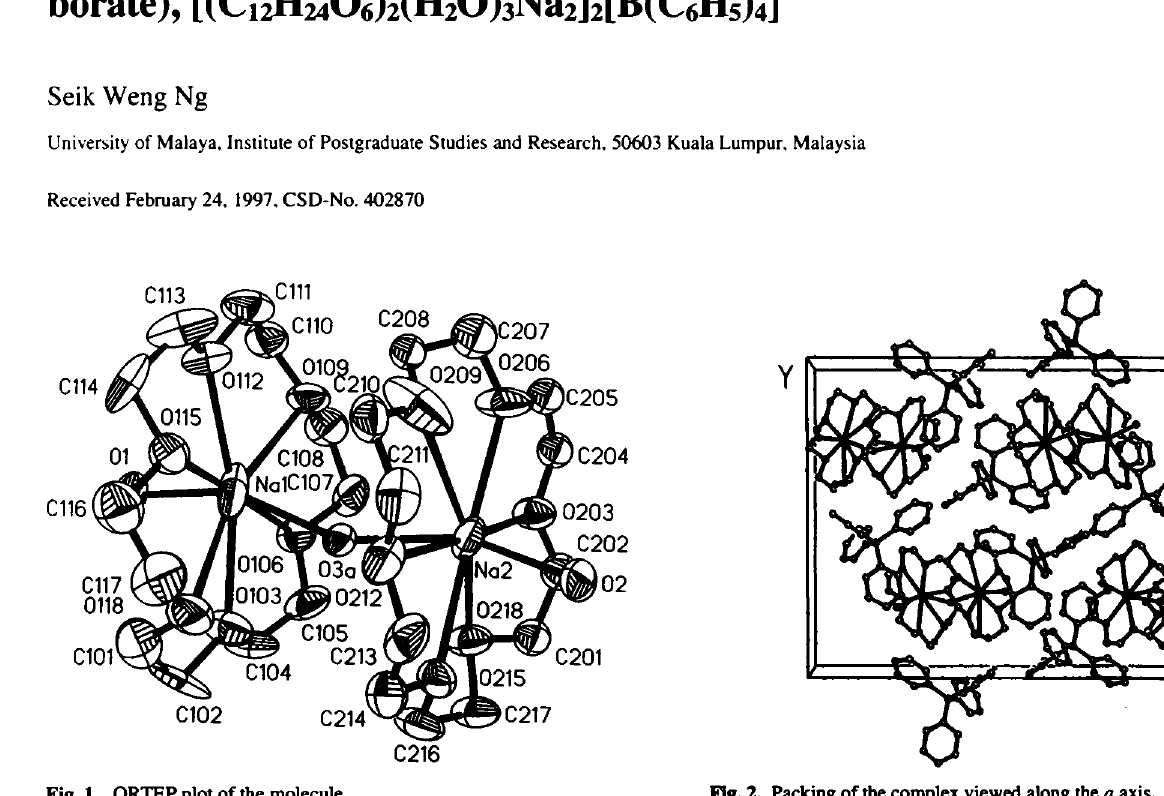
Fig. 1. ORTEP plot of the molecule.